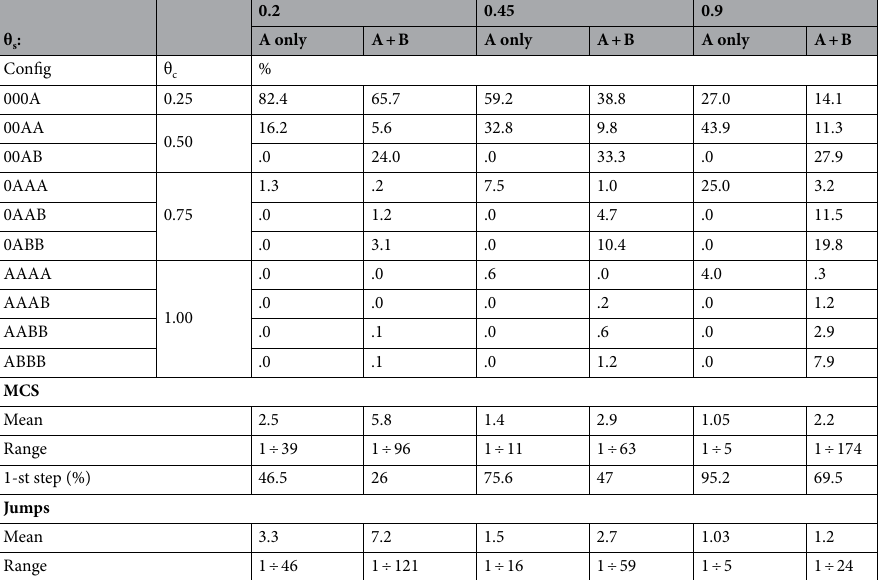
Table 2. Results of the kinetic Monte Carlo simulations of the surface diffusion on 11 × 11 lattice; started with certain coverage of the substrate and free border, finished when A is registered at the border; averaged over 10 6 runs; θ s is the substrate coverage, θ c is the coverage corresponding to particular configuration, configuration means specific filling of the border with adsorbate (only configurations with A are included), MCS is the Monte Carlo step at which run stops, 1-st step (%) is the percentage of runs finished at first MCS, Jumps is the number of diffusion jumps made by particle A before reaching the